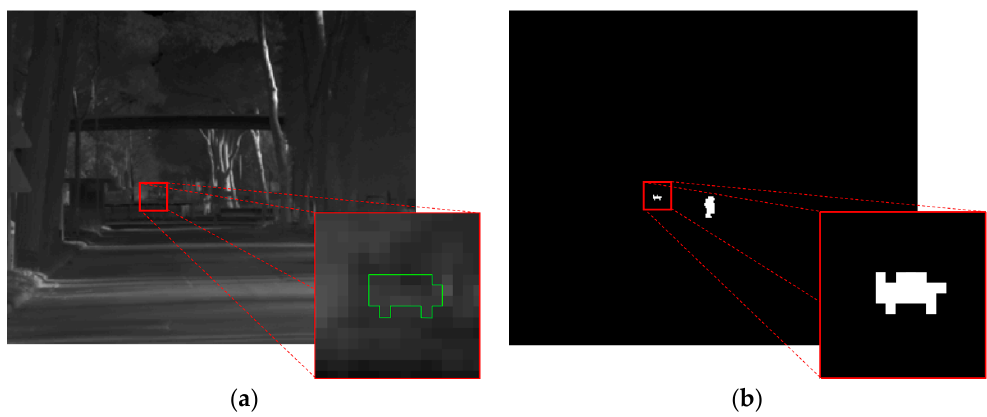
Figure 5. Example frame of a video sequence containing two moving objects one of which is dim pointed out by the green contour in the zoomed box ( a ); and corresponding detection map output by the proposed algorithm ( b ) again the region containing the dim object is pointed out in a zoomed box.